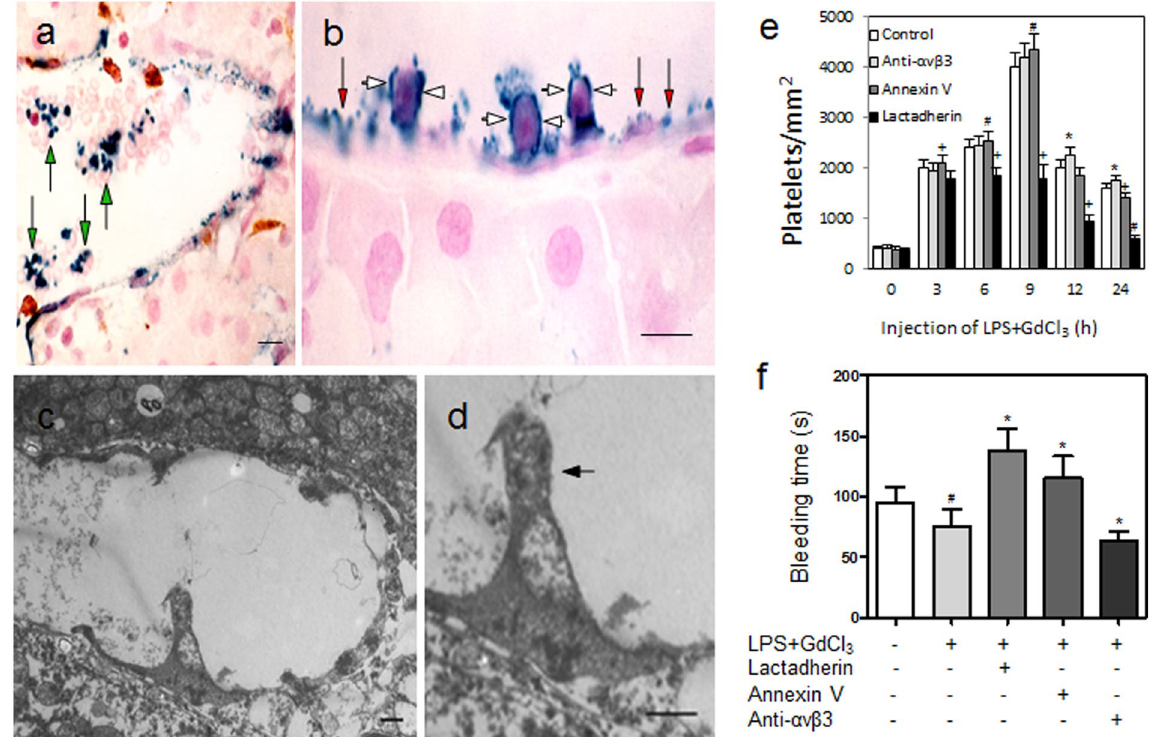
Figure 4. Phagocytosis of platelets by ECs in vivo . Rats were injected with LPS and the livers were taken at 6 h after perfusion fixation ( a – d ). ( a , b ) Platelets were immunolabeled with anti-P-selectin antibody (blue) and counterstained with nuclear fast red (red). Many platelets expressing P-selectin were found adhering on ECs in the portal vein (red arrows) and also formed aggregates with leukocytes (white arrows) and erythrocytes (green arrows) in the liver. ( c , d ) Transmission electron microscopy images further confirmed engulfment and partial digestion (arrow) of the platelets by the ECs in vivo . Bars represent 2 μ m ( c , d ) and 10 μ m ( a , b ). Mice were also injected with LPS to induce septic conditions and GdCl 3 to block the function of Kupffer cells in the liver ( e , f ). ( e ) Platelet number in the liver was counted and present as number/mm 2 with various treatments in different time points. Each value is expressed as mean ± SD of 10 mice. * # + P < 0.05 versus control. ( f ) Septic mice were pretreated with lactadherin, annexin V, or anti- α v β 3 antibody, and tail-bleeding time was evaluated. Each value was expressed as mean ± SD of 10 mice. * P < 0.05 versus mice only treated with LPS and GdCl 3 , # P < 0.05 versus untreated